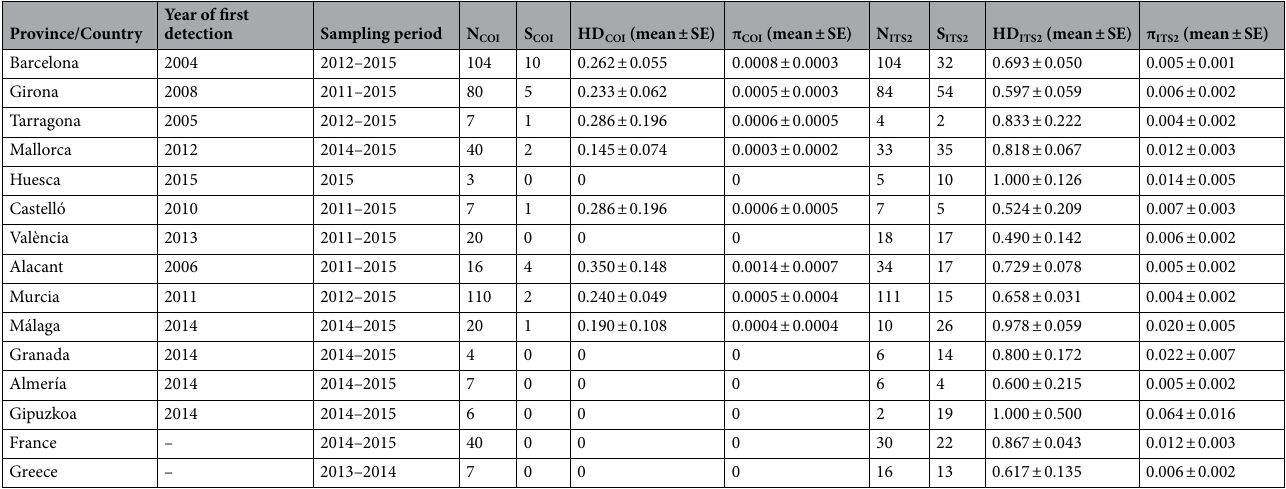
Table 1. Basic genetic statistics of Ae. albopictus sampled provinces and countries for mtDNA (COI) and nuclear DNA (ITS2). N, sample size; S, number of polymorphic sites; HD, haplotype diversity; π, nucleotide diversity. Note that each province contains multiple sampling sites, as shown in Fig.